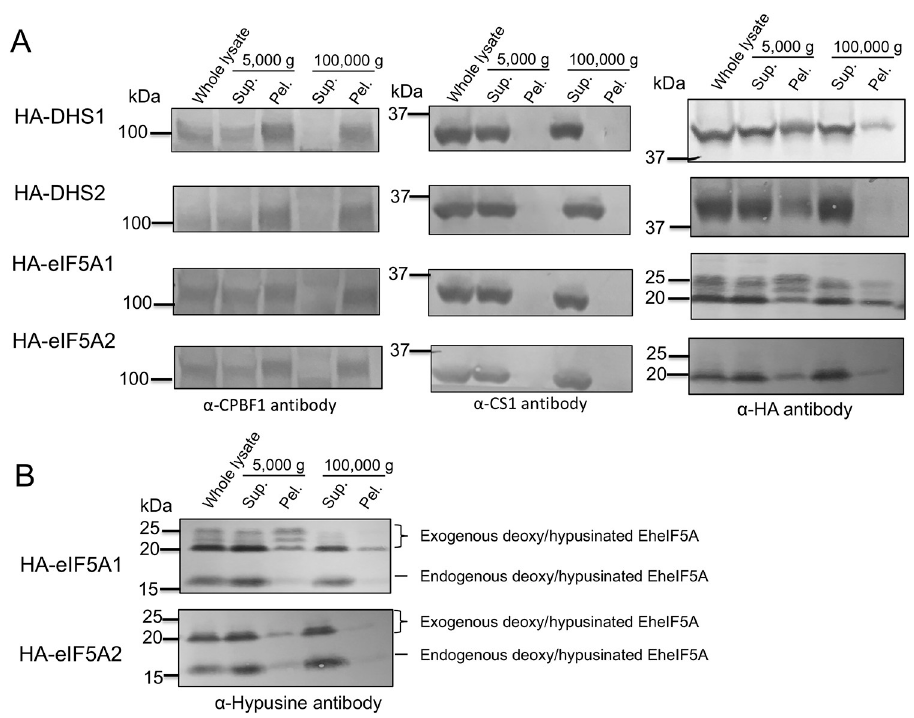
Fig 6. Cellular distribution of EhDHS and EheIF5A isoforms and post translational modification of EheIF5A1/2. (A) Cellular fractionation of EhDHS1, EhDHS2, EheIF5A1, and EheIF5A2. Trophozoites of the transformants expressing HA-tagged EhDHS1, EhDHS2, EheIF5A1, and EheIF5A2 were fractionated as described in Materials and Methods, and subjected to immunoblot analysis using anti-HA monoclonal antibody, anti-hypusine, anti-CPBF1, and anti-CS1 polyclonal antisera. CPBF1 and CS1 served as control of organelle and cytosolic proteins, respectively. (B) PTMs of HA tagged EheIF5A. Approximately 30 μ g of total lysates from the transformants expressing HA-tagged EheIF5A1 and EheIF5A2 were subjected to SDS-PAGE under reducing conditions and immunoblot analysis using anti-hypusine antibody.